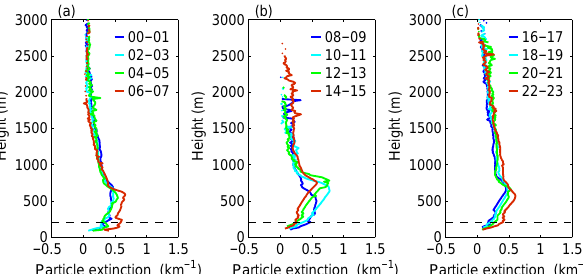
2h for (a) 00:00–07:00LT, (b) 08:00–15:00LT, and (c) 16:00–